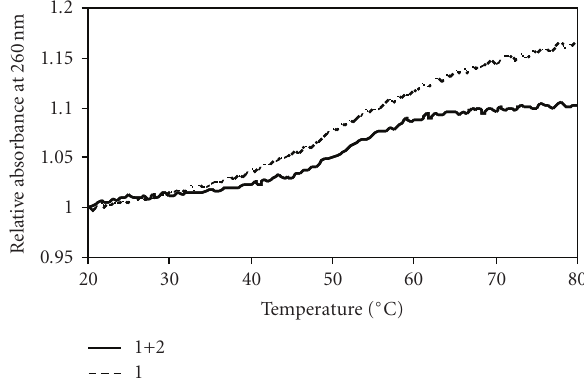
Figure 1: Melting curves of parallel clamp 1 and the complex formed by 1 and its target 2 (Conditions 50mM MgCl 2 , 10mM sodium cacodylate pH 7.2).